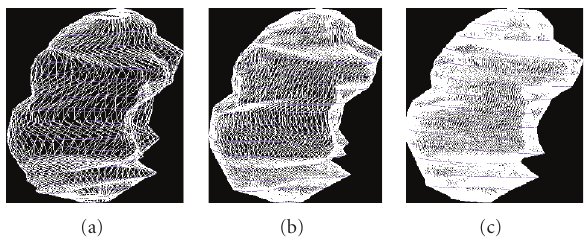
Figure 15: Reconstruction of brain tumor: 50 points, 100 points, and 200 points on the contours.